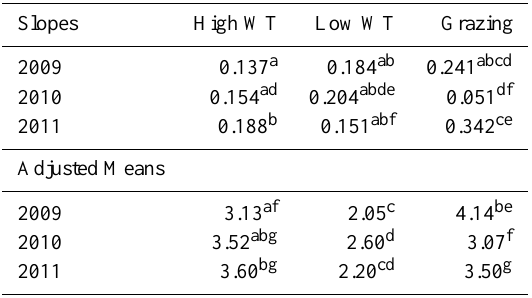
Fig. 5. Daily CH 4 fluxes observed over three years in relation to soil temperature at 20cm depth. Different symbols indicate periods with low and high water table and periods with (black dots) and without grazing, respectively. Table 4. ANCOVA results for the log-transformed temperature re- sponse of the CH 4 flux for different years and treatments. Combina- tions of year and treatment without a common letter are statistically different ( P <0.05).